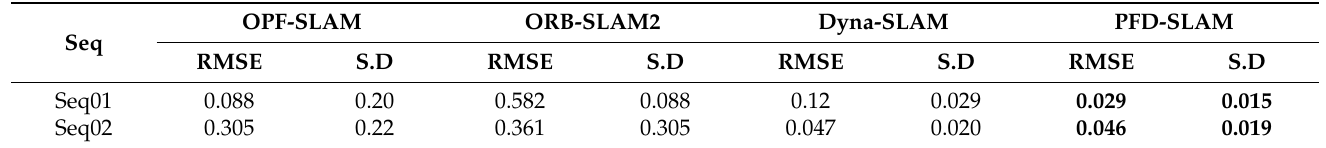
Table 5. Comparisons of ATE-RMSE (m) in real scenes.